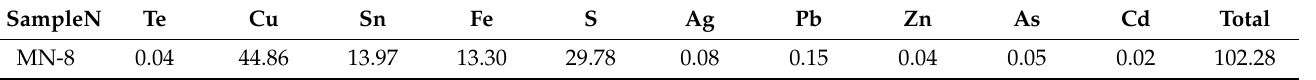
Table 5. Electron microprobe analyses for wittichenite (wt.%). Analyses No.